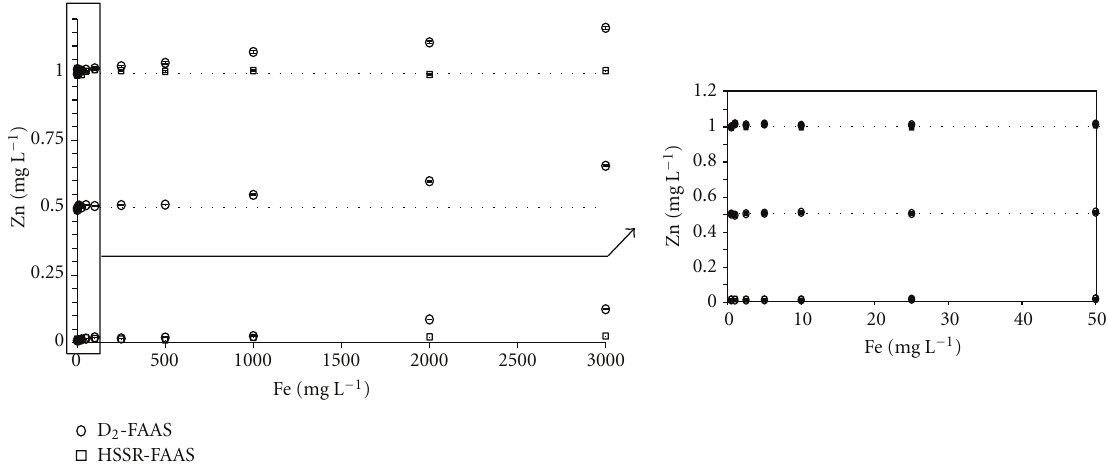
Figure 4: Influence of Fe on the three concentrations of Zn (0.01, 0.5, and 1 mgL − 1 ) measured in 0.11 M acetic acid by FAAS at 213.856 nm with the D 2 and HSSR methods.